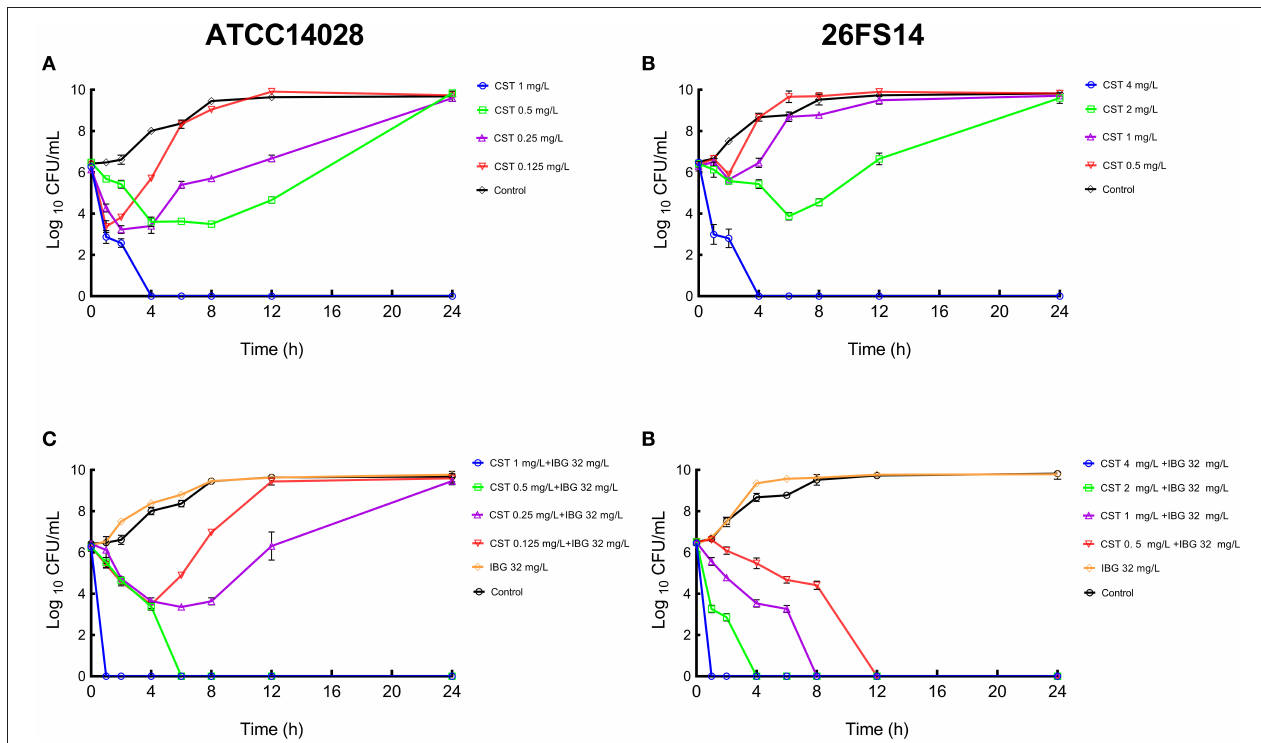
FIGURE 1 | In vitro time-kill curve of colistin alone (A,C) and combined with IBG (B,D) against Salmonella ATCC14028 (left) and 26FS14 (right). A growth control without drug administration was included in all the tests. CST, colistin; IBG, isopropoxy benzene guanidine.